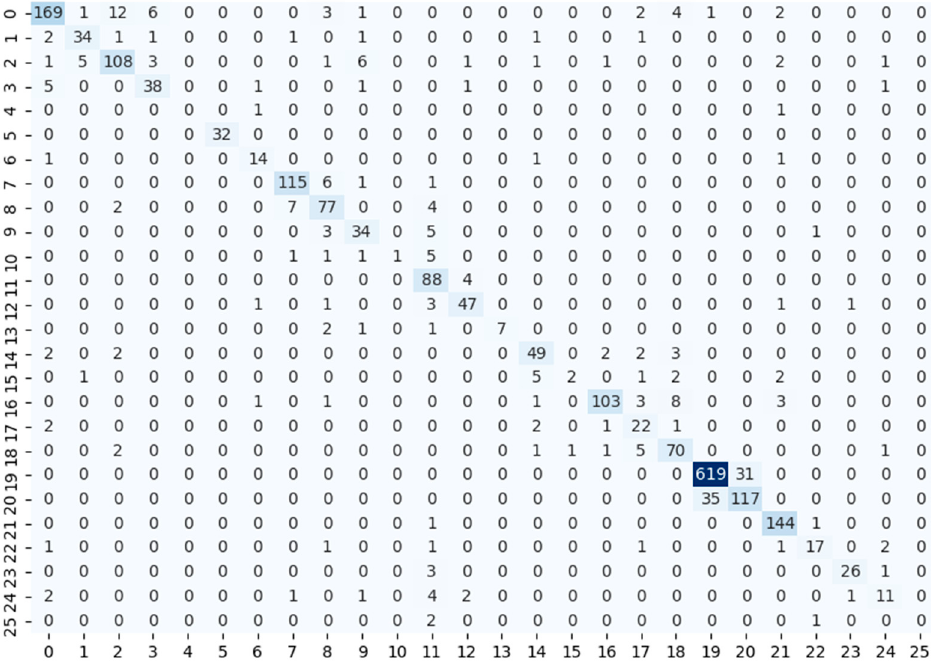
Figure 5. Confusion matrix for the test